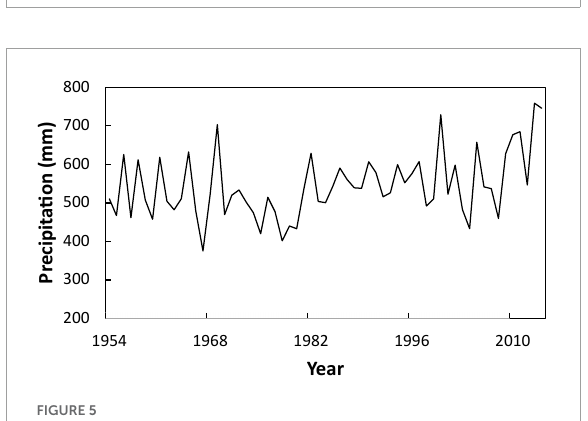
FIGURE4 Changes of average temperature since 1954 in the Sanjiang Plain.